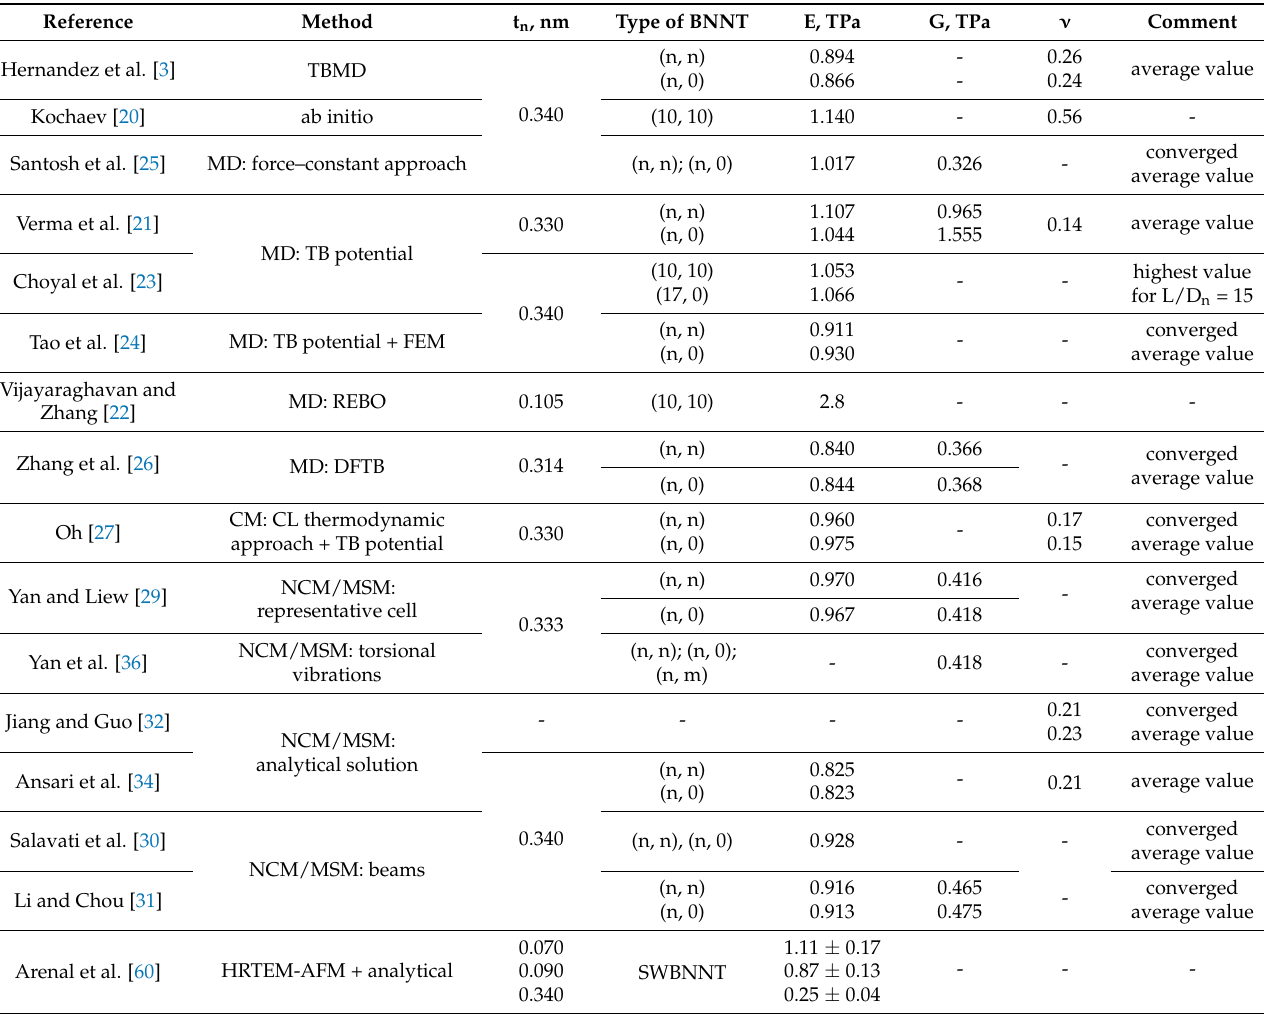
Table 8 summarised the current results on the elastic property of SWBNNTs and also those from literature, including theoretical and experimental results. Table 8. A comparison of the current Young’s and shear moduli and the Poisson’s ratio results for boron nitride nanotubes with those reported in the